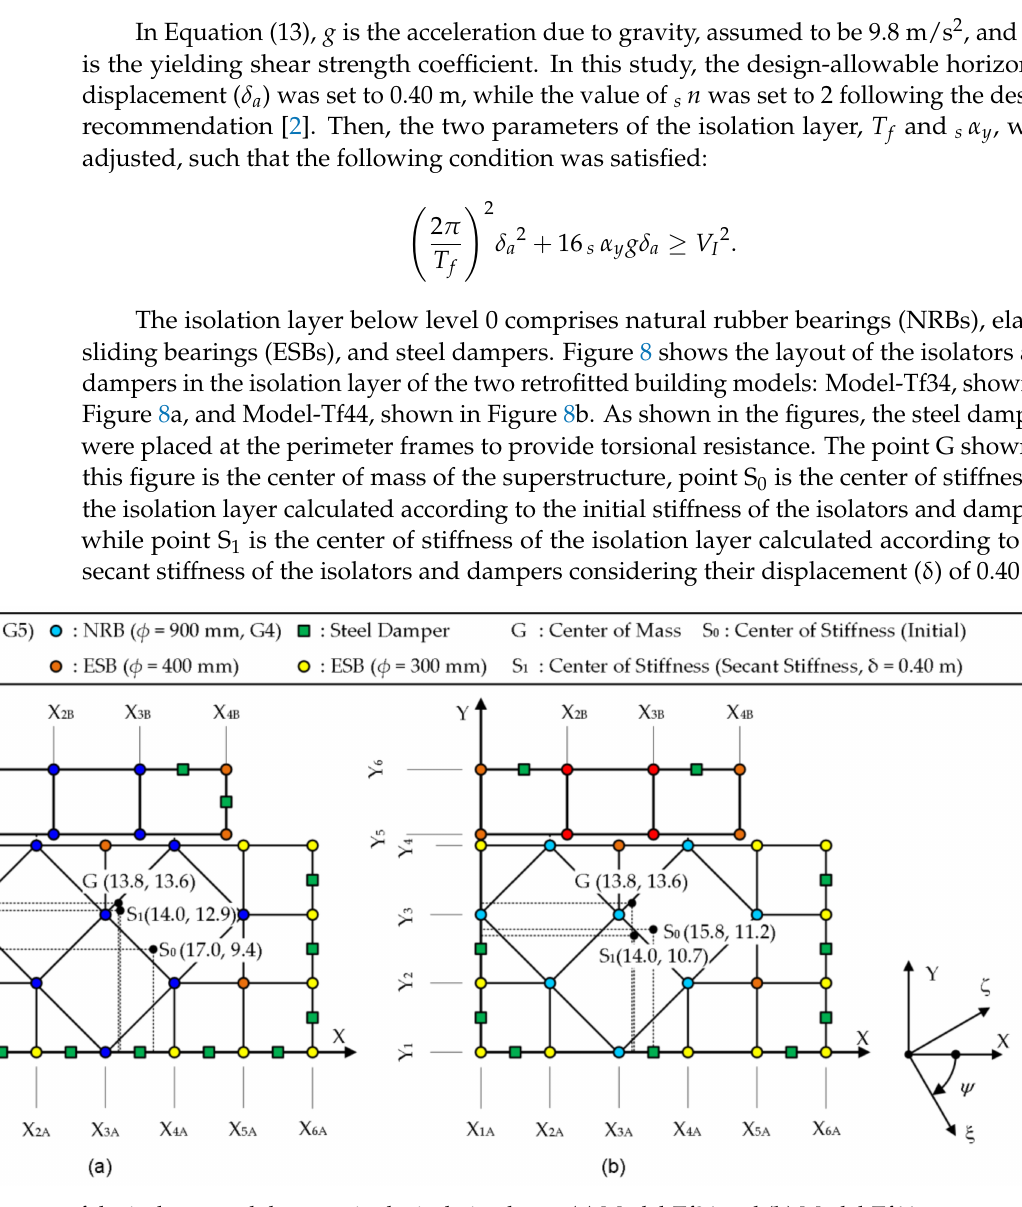
Figure 8. Layout of the isolators and dampers in the isolation layer: ( a ) Model-Tf34 and ( b ) Model-Tf44. For Model-Tf34, T f = 3.38 s and s α y = 0.0448, while for Model-Tf44, T f = 4.40 s and s α y = 0.0396. Note that T f was calculated according to the horizontal stiffness of the NRBs, while s α y was calculated according to the yield shear strength of the ESBs and steel